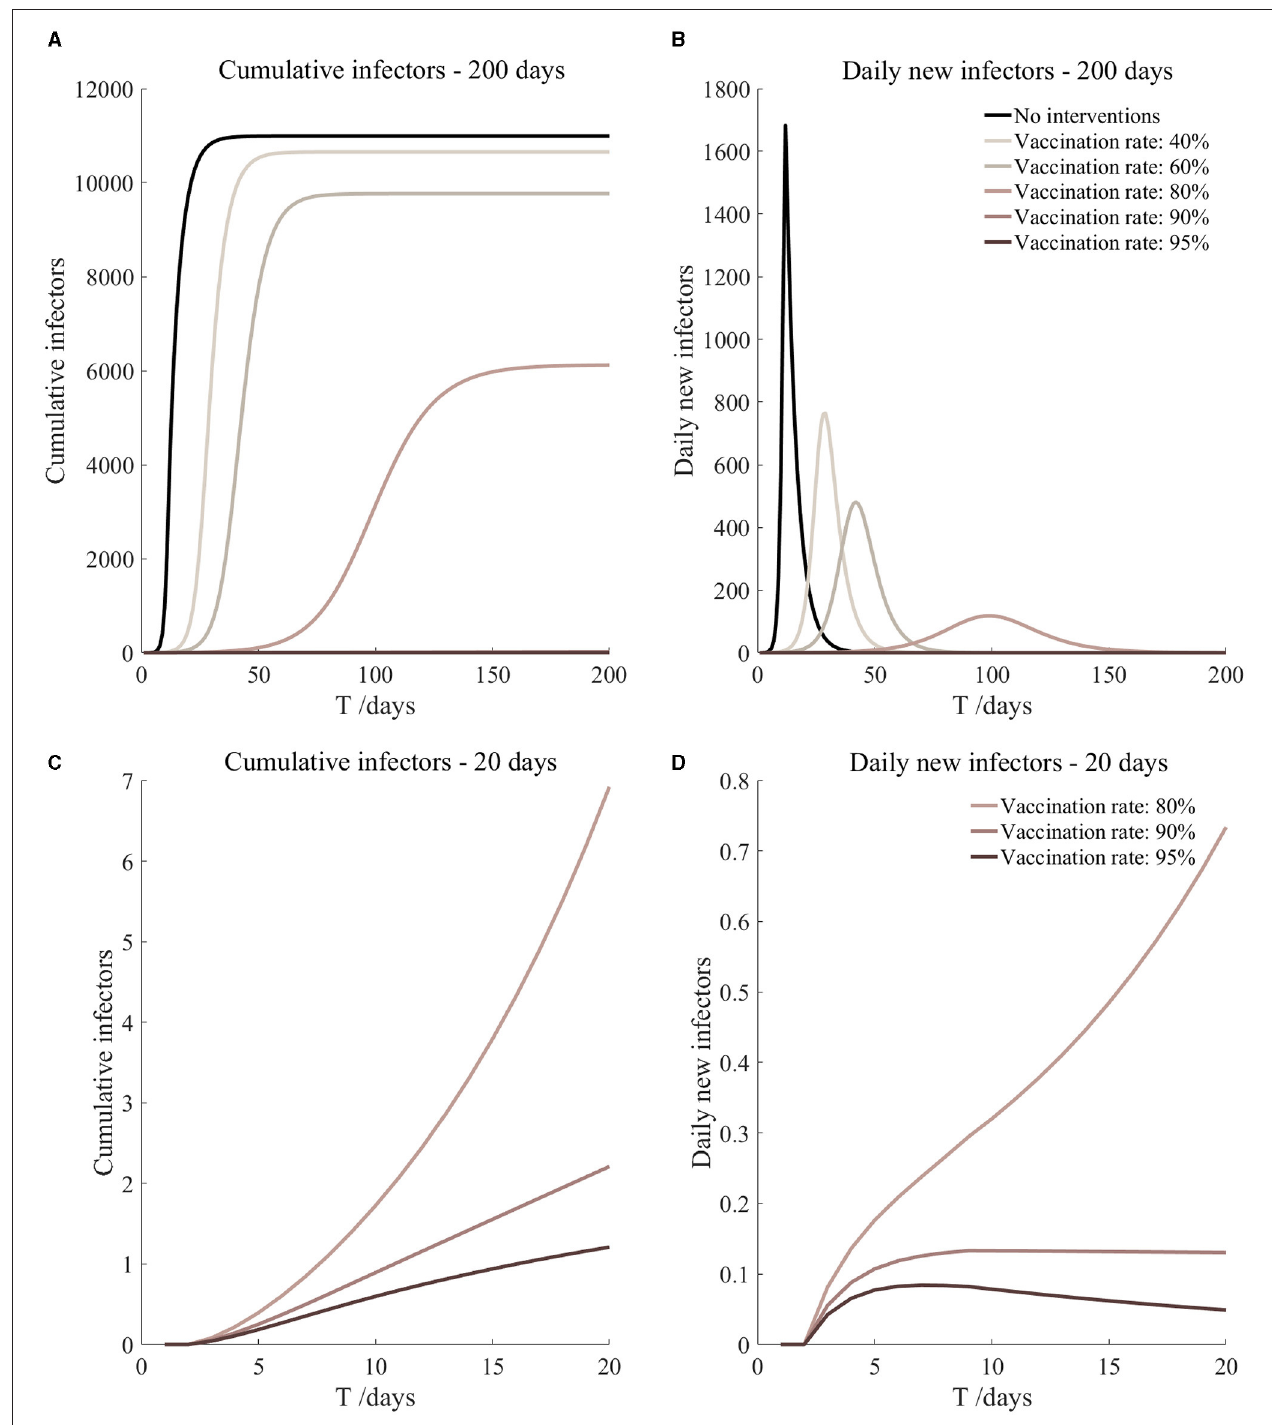
FIGURE 11 | Vaccinated but not quarantined. Assume pre-flight screening can identify 20% of asymptomatic infectors.